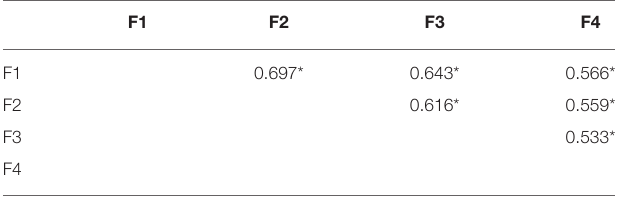
TABLE 3 | Inter-item correlation